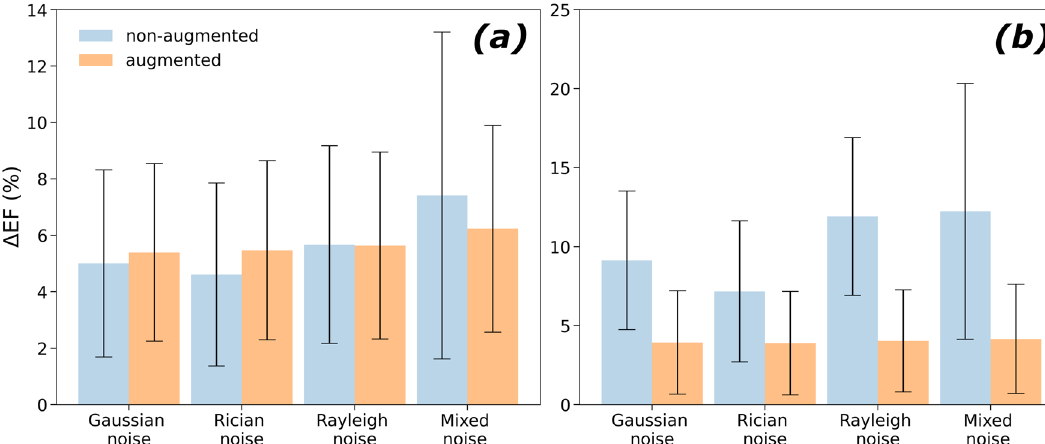
Figure 4. EF mean absolute difference in different noise scenarios between non-augmented (original) and augmented model for one-model segmentation approach ( a ) and two-model segmentation approach ( b ). The bars represent the standard deviation.